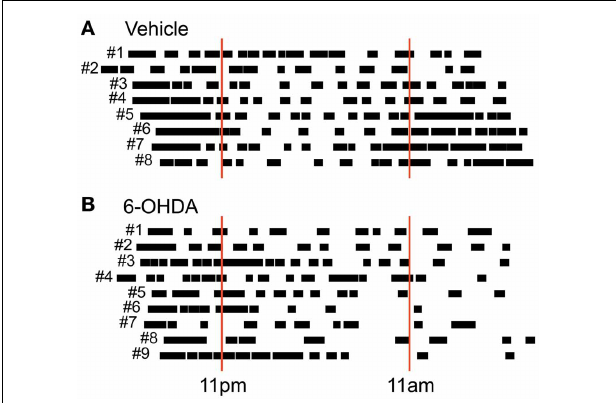
FIGURE 3 | Circadian post-lesion activity. Free locomotor activity of all vehicle (A) and all 6-OHDA (B) injected rats after lesioning. Animal numbers are given left to the respective vertical bars representing global activity phases. Red solid lines mark light switches at 11pm (lights on) and 11am (lights off) that would take place under usual housing conditions. Note that behavioral monitoring was performed under constant dark